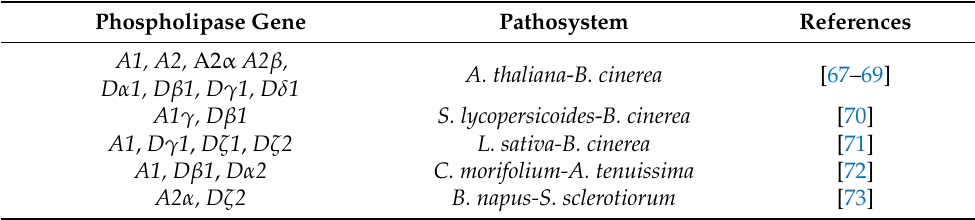
Table 1. Phospholipase ( PL ) genes encoding different isoforms of PLA and PLD active in various